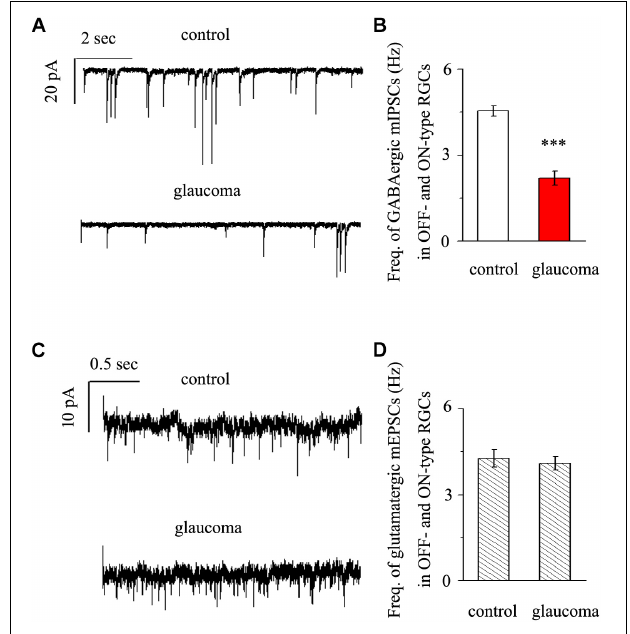
FIGURE 3 | Effects of chronic glaucoma on retinal mIPSCs and mEPSCs. (A) Representative traces of voltage clamp recordings of GABAergic mIPSCs in the presence of TTX (1 µ M) in control and glaucomatous retinas. The baseline frequency of mIPSCs was markedly lower in glaucomatous retinas than in control retinas. Vertical scale bar, 20 pA; horizontal scale bar, 2 s. (B) Bar graphs showing the mean frequency of mIPSCs in control and glaucomatous retinas. (C) Representative traces of voltage-clamp recordings of glutamatergic mEPSCs in the presence of TTX (1 µ M) in control and glaucomatous retinas. The baseline frequency of mEPSCs did not differ between glaucomatous retinas and control retinas. Vertical scale bar, 10 pA; horizontal scale bar, 0.5 s. (D) Bar graphs showing the mean frequency of mEPSCs in control and glaucomatous retinas. ∗∗∗ p < 0.001, unpaired Student’s t